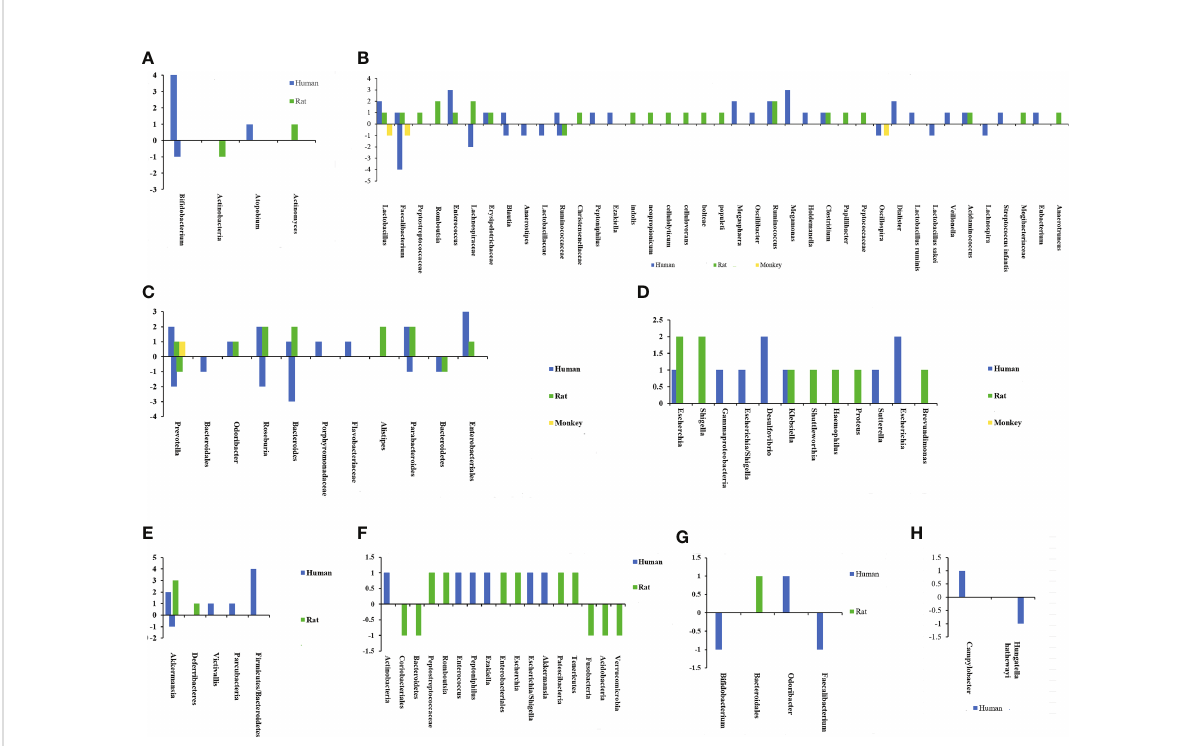
FIGURE 2 Chart of intestinal fl ora changes in cerebrovascular diseases. The abscissa represents different bacteria, and the ordinate shows the number of changes in fl ora. (A) Changes of actinobacteria after ischemic stroke. (B) Changes of Firmicutes after ischemic stroke. (C) Changes of Bacteroidetes after ischemic stroke. (D) Changes of Proteobacteria after ischemic stroke. (E) Changes of other bacterias after ischemic stroke. (F) Changes of intestinal fl ora after intracerebral hemorrhage. (G) Changes of intestinal fl ora after cerebral cavernous hemangioma. (H) Changes of intestinal fl ora after intracranial